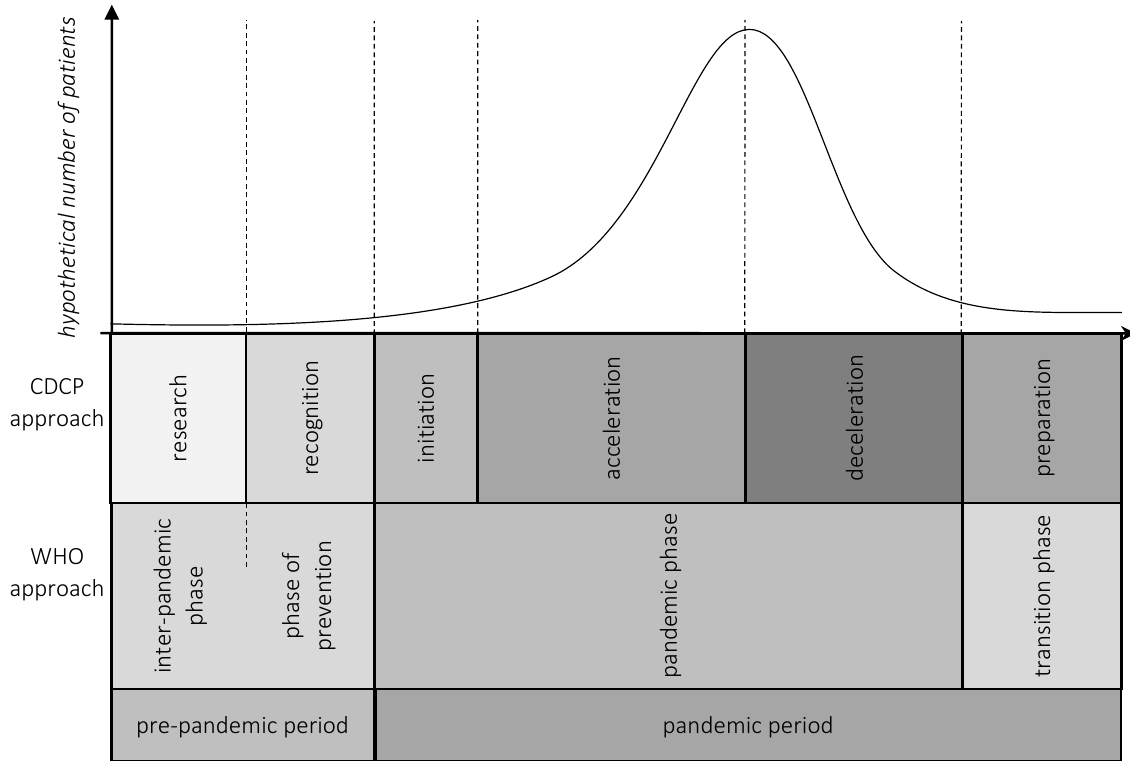
Figure 4. Pandemic lifecycle architecture